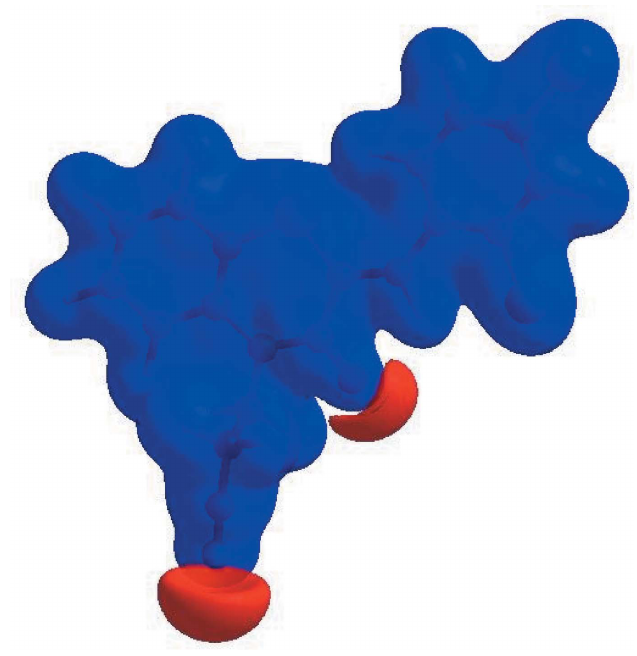
Figure 5 View of the three-dimensional Hirshfeld surface of the title compound plotted over electrostatic potential energy in the range (cid:3) 0.0500 to 0.0500 a.u. using the STO-3 G basis set at the Hartree–Fock level of theory. Hydrogen-bond donors and acceptors are shown as blue and red regions around the atoms corresponding to positive and negative potentials, respectively.